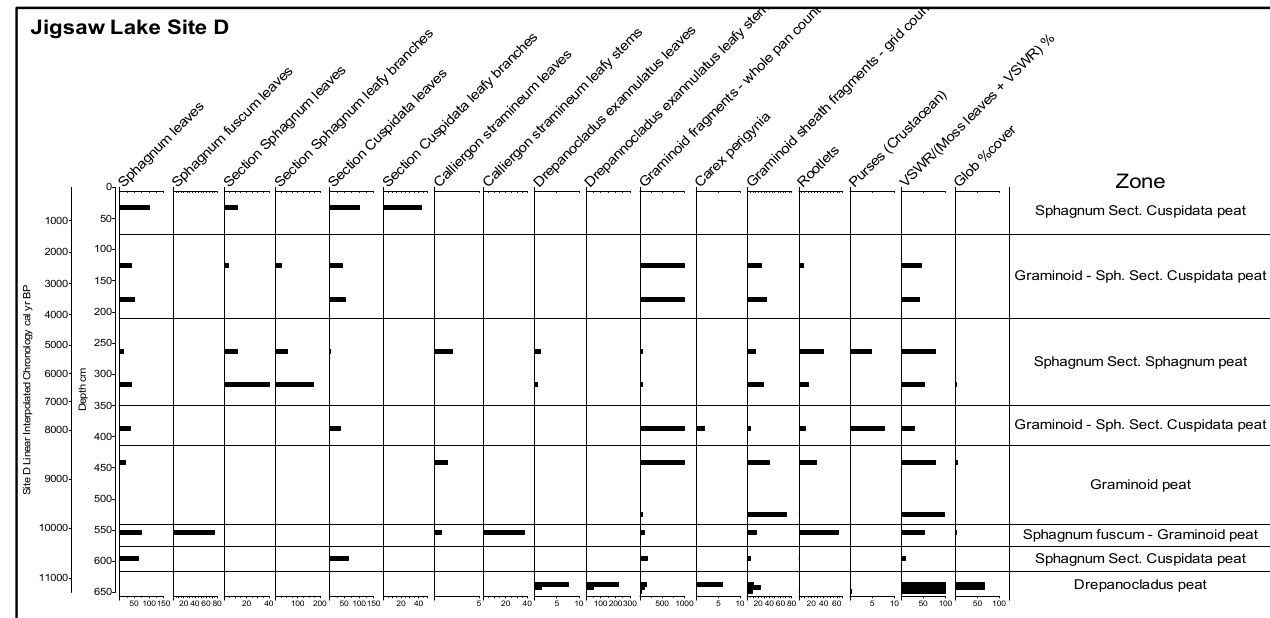
Figure 7. Jigsaw Lake Fen D macrofossils. The chronology is based on linear interpolation with six AMS radiocarbon dates. Particle count units are particles/cm 2 ; vascular composition and amorphous gel cover are percentages. The earliest vegetation is Drepanocladus exannulatus , probably in very shallow standing water. As the first meter of peat accumulates, dry Sphagnum fuscum hummocks dominate briefly, likely by autogenic succession, and then wet graminoids appear, commensurate with peat sloughing off the lake margins as lake levels start to rise ~10.3 ka. The Jigsaw Lake fen peats are summarized in a topographical profile in Figure 8. Peat core sections from satellite fens are arranged clockwise around the lake from west to east. Green overlay shows wet fen conditions, brown overlay shows drier fen conditions. Maximum lake levels are estimated from the Fen D trajectory in Figure 9. Dotted lines show two important isochrons: 9.2 ka when lake level rise slows from the early rapid rise period, and 4.8 ka when the Cove Fen begins to flood and shift back to wetter vegetation. All cores terminated in mineral soil; basal dates are shown at the core bottoms. The variation in fen elevations is simply due to the kettle moraine topography upon which these fens are perched (Figure 2); no trend should be interpreted from the horizontal arrangement of the cores in the